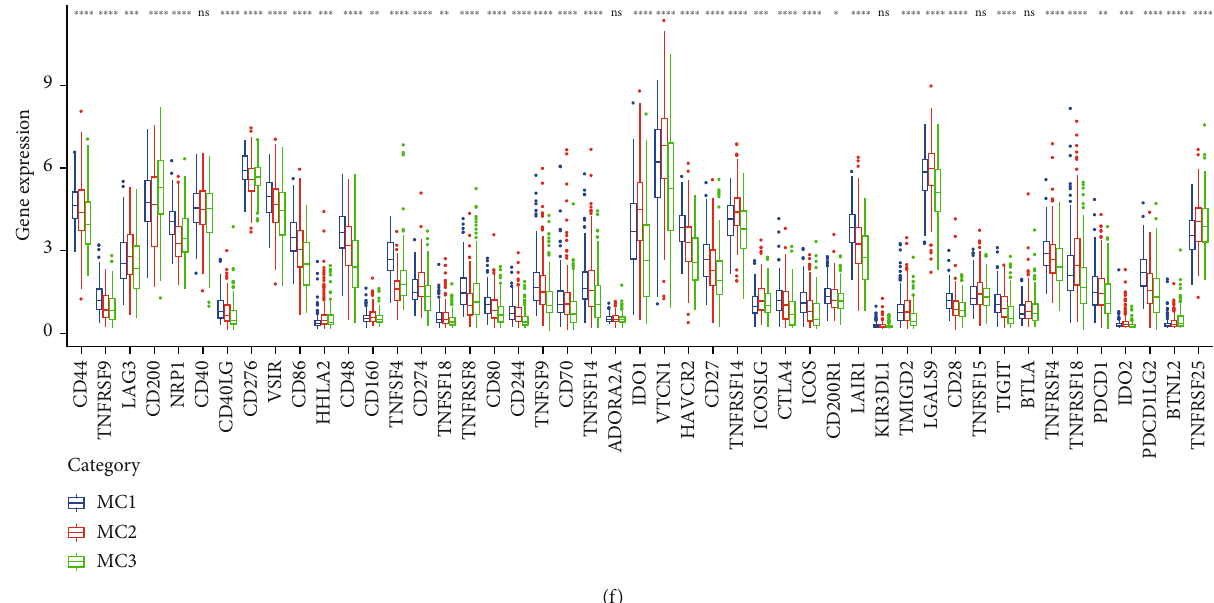
Figure 3: (a) Di ff erence in the expression and distribution of chemokines in the RNASeq cohort. (b) Di ff erence in the expression and distribution of chemokine receptors in the RNASeq cohort. (c) Di ff erence in the distribution of IFN γ scores among the di ff erent subgroups in the RNASeq cohort. (d) Di ff erences in the immune T cell lysis activity among the di ff erent subgroups. (e) Di ff erences in the angiogenesis scores among the di ff erent subgroups. (f) Di ff erences in the expression and distribution of immune checkpoint genes in the RNASeq cohort; the signi fi cance is statistically tested using analysis of variance. ∗ P < 0 : 05 , ∗∗ P < 0 : 01 , ∗∗∗ P < 0 : 001 , and ∗∗∗∗ P < 0 : 0001